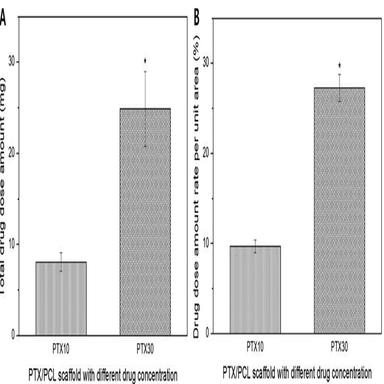
Total drug dose amount (A), Drug dose amount rate per unit area (B) of PTX/PCL scaffold with different drug concentration (standard size of PTX/PCL scaffold: Φ 9–85 mm) (\p < .01 compared with the PTX10 group).